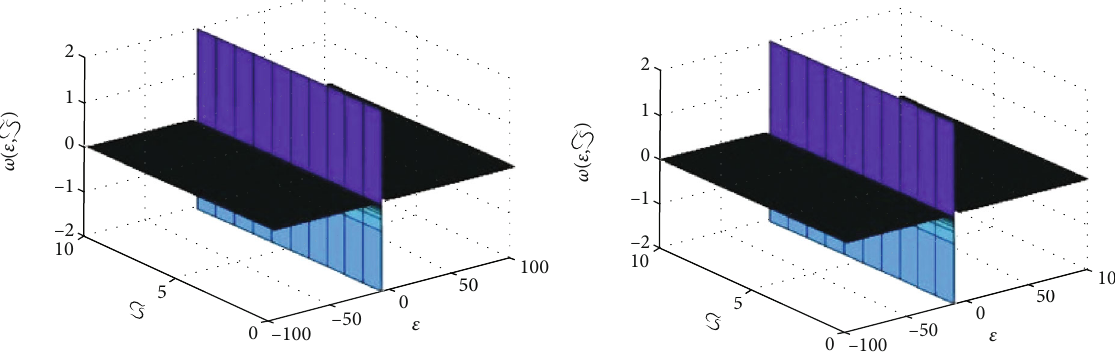
Figure 4: Exact and approximate solution of ω ð ε , I Þ at ϑ = 1 .